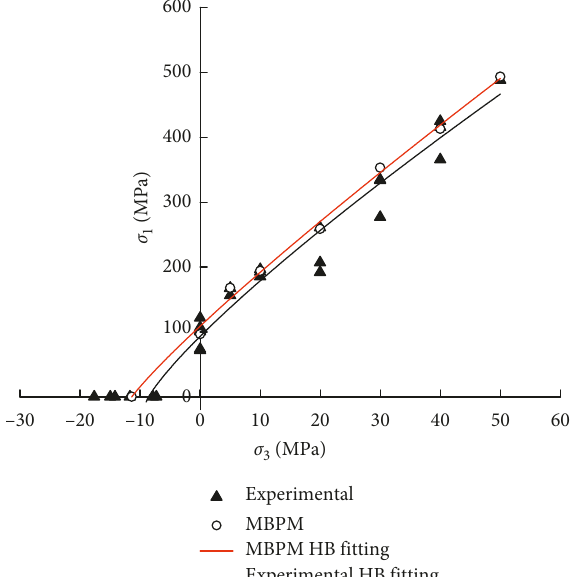
Figure 21: Hoek–Brown strength envelopes from experimental results and numerical